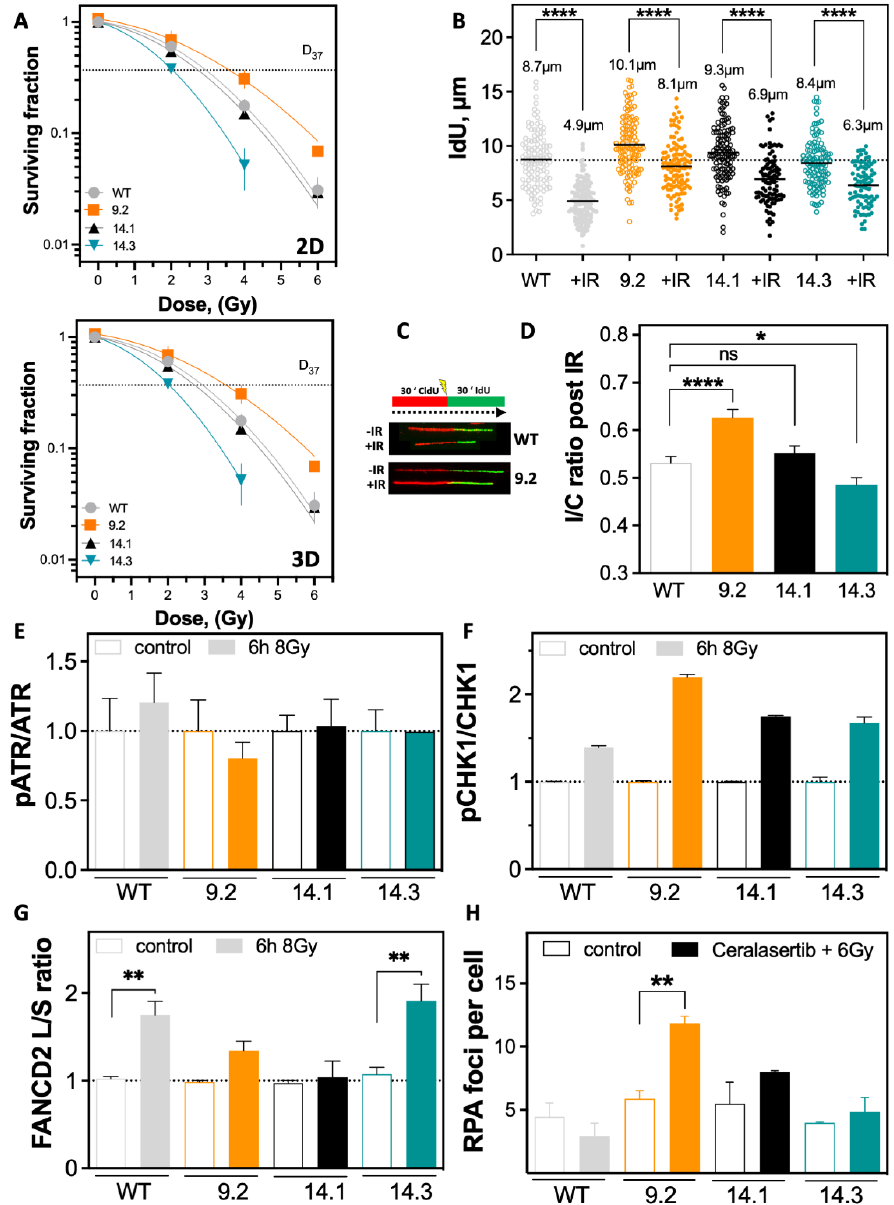
Figure 4. Less DNA replication stress is associated with resistance to irradiation. ( A , B ) Differences in cellular survival after irradiation in 2D and 3D cultures. Cells were seeded 12 h before IR, fixed after 14 days, and the number of colonies with >50 cells was determined. ( B – D ) DNA fiber assay after irradiation with 6 Gy, in MCF7 WT and BRCA1 mutated clones. ( B ) Treatment scheme shows sequential labeling with CldU and IdU for 30 min each and IR between both labels. Incorporated nucleotides were detected by immunofluorescence. The length of the DNA fibers was measured with the Image J 1.52n software. ( C ) DNA fiber length of DNA strands after IR (IdU) and ( D ) the ratio of DNA fiber length pre to post irradiation (I/C ratio) was calculated. ( E – G ) Activation of ATR,